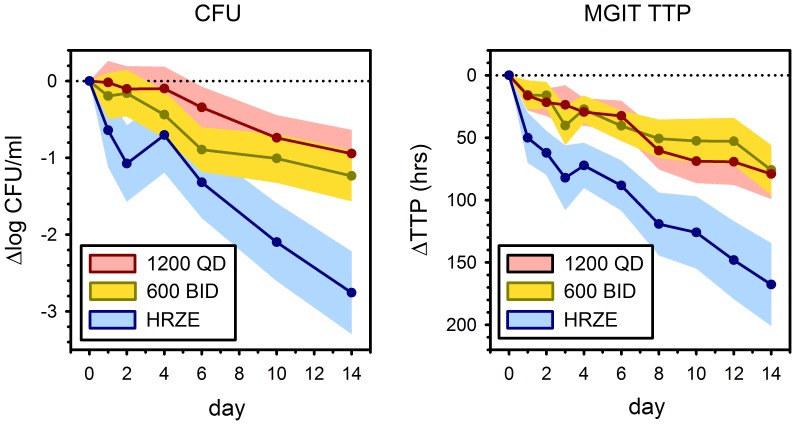
Bactericidal activity in sputum according to treatment arm as assessed by colony counts (left) and time to positivity in automated liquid culture (MGIT TTP, right).Lines indicate prediction and shading 90% confidence interval (CI) as determined by mixed effects model repeated measures analysis, using day as a categorical variable. The vertical axis of the right hand figure is inverted to facilitate visual comparison with CFU findings. At 14 days, the 90% CI of all treatments excluded zero.